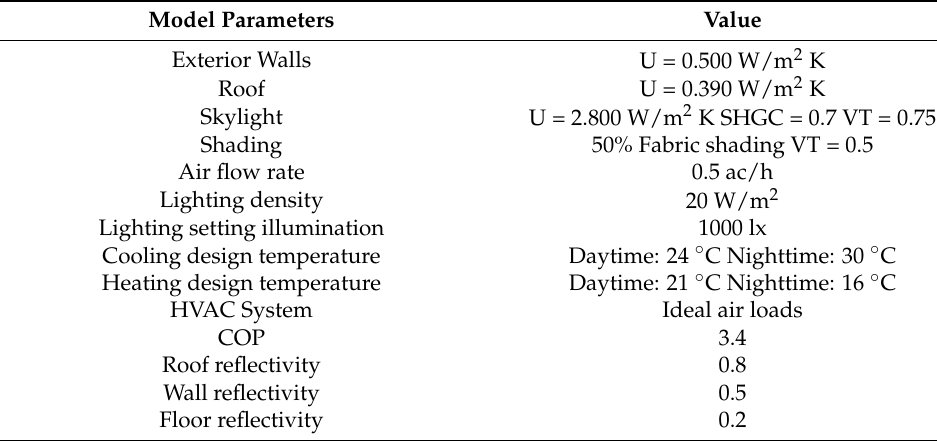
Figure 8. Commercial atrium baseline model. Table 3. Baseline model parameter